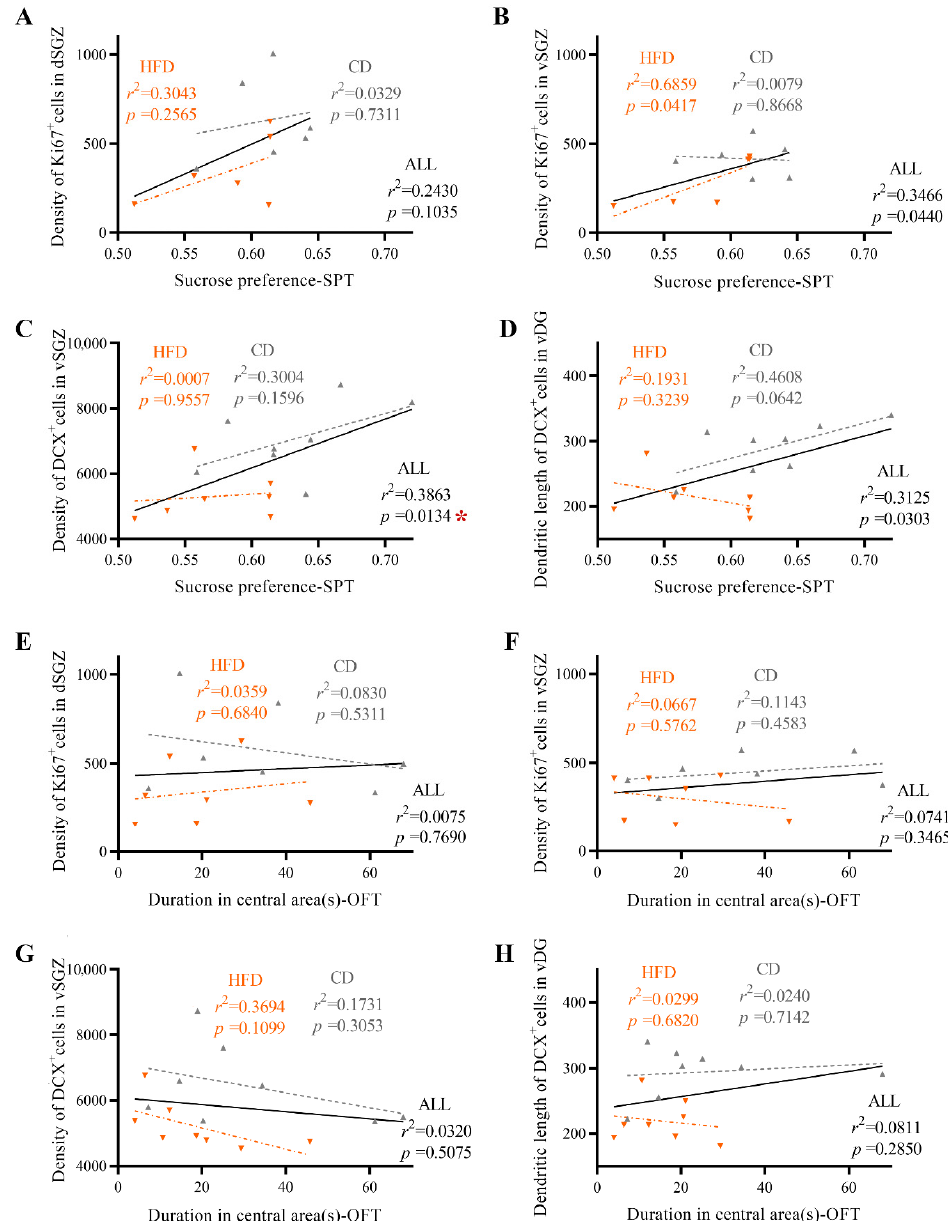
Figure 5. Linear regression analysis of hippocampal neurogenesis and depression-like and anxiety- like behavior. ( A , B ) Correlation between the density of Ki67 + cells in the dSGZ/vSGZ and sucrose preference in the SPT. ( C ) Correlation between the density of DCX + cells in the vSGZ and sucrose preference in the SPT. ( D ) Correlation between the dendrite length of DCX + cells in the vDG and sucrose preference in the SPT. ( E , F ) Correlation between the density of Ki67 + cells in the dSGZ/vSGZ and the time spent in the central area in the OFT. ( G ) Correlation between the density of DCX + cells in the vSGZ and time spent in the central area in the OFT. ( H ) Correlation between the dendrite length of DCX + cells in the vDG and the time spent in the central area in the OFT. Mice from both the CD group (represented as gray triangles) and HFD group (represented as orange triangles) are included ( n = 6–8 mice per group). The solid black lines, gray dotted lines, and orange dotted lines indicate linear regression for mice fed a CD or HFD, mice fed a CD, and mice fed an HFD, respectively. * means statistical significance after Bonferroni